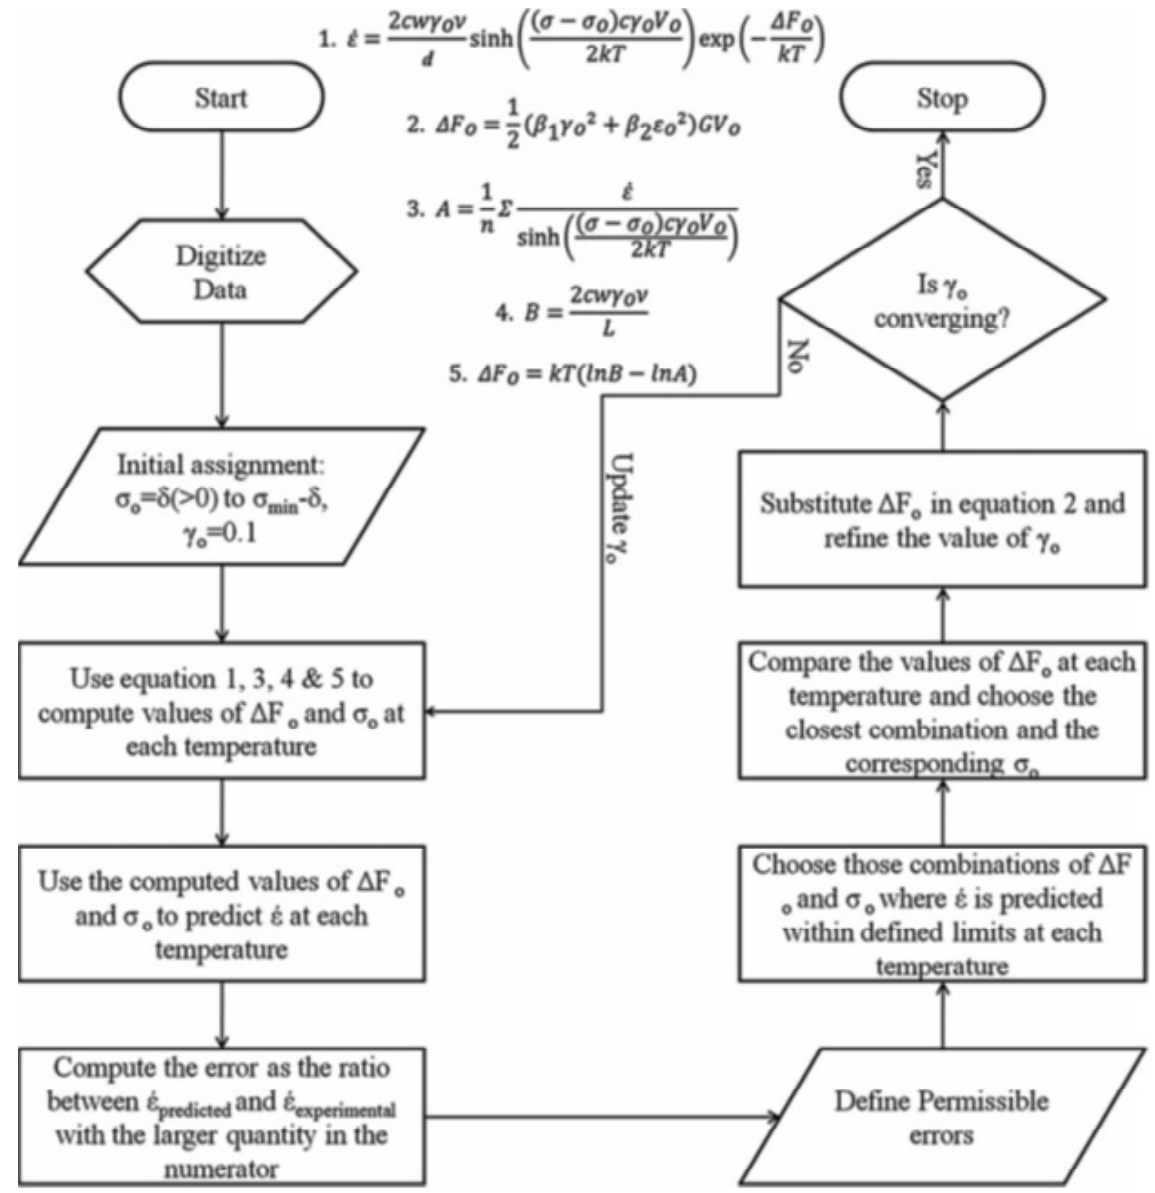
Fig. 4. Flow chart describing the algorithm used for computing the free energy of activation,  F shear strain  , the threshold stress for the onset of mesoscopic boundary sliding,  0 strain rate under the given experimental conditions,   (see our work